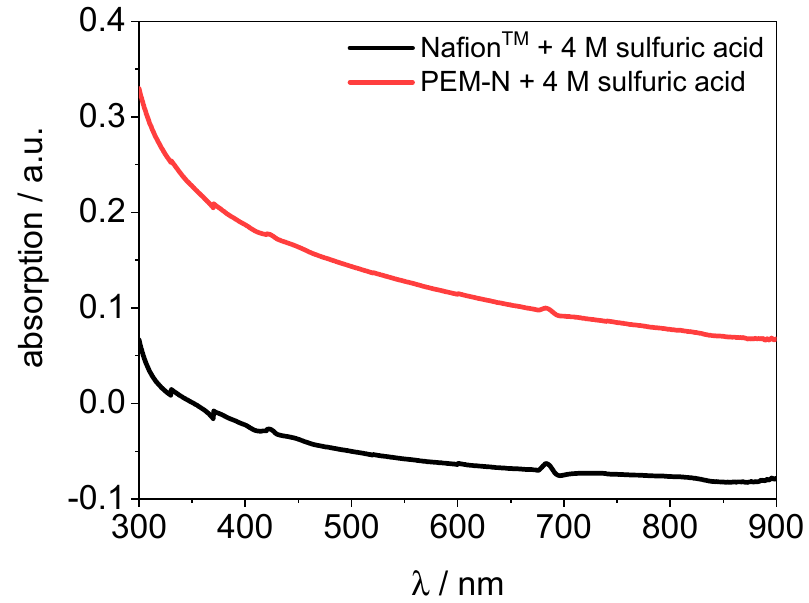
Figure 8. UV/VIS spectra of Nafion™ and a PVDF-based membrane hydrated with 4 M sulfuric acid.